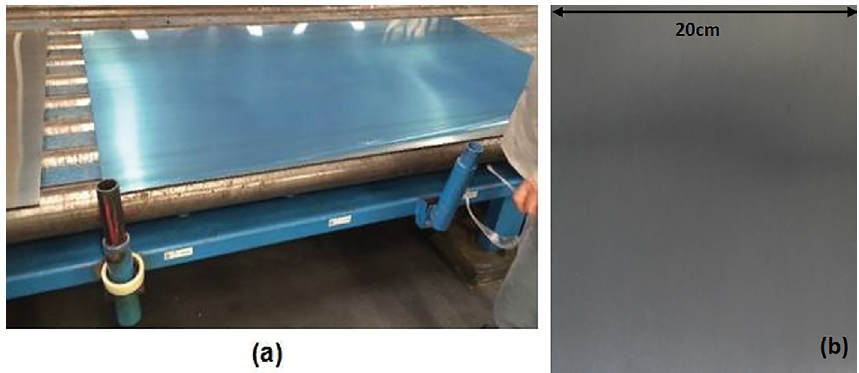
Figure 10. a) Picture of rolled AA5052 sheet highlighting the surface quality after the employ of proposed B2 foundry condition (1200mmx2000mmx0.80mm sheets), b) detail of a rolled sheet surface without